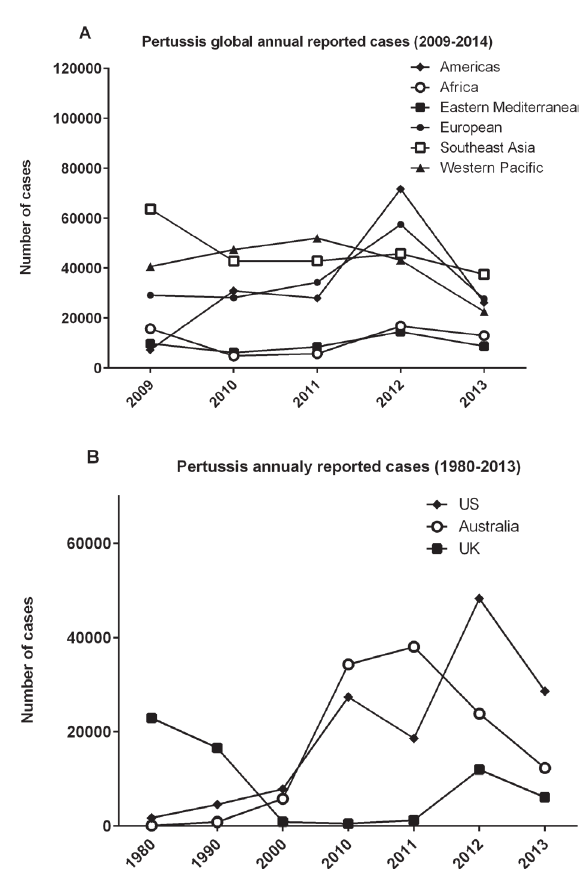
Figure 4 - Pertussis global annual cases. a , annual cases in the world (2009-2013), countries are distributed by regions; B , pertussis cases in the US, Australia and UK (1980-2013); data summarized from WHO (2014) and CDC (2014);